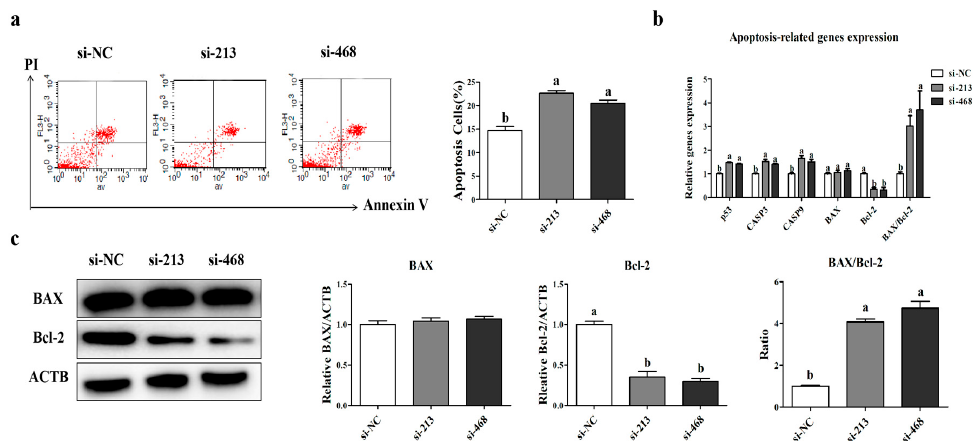
Figure 7. Apoptosis rates after transfection were determined by flow cytometry ( a ). Apoptosis-related gene expression ( b ) and apoptosis-related protein expression ( c ) in the transfected myoblasts were determined using qRT-PCR and Western blot, respectively. The expression of genes and proteins was normalized to β -actin ( ACTB ) and related to si-NC as mean values ± SEM ( n = 3). a, b, c: different letters denote statistically significant differences within each group; p < 0.05.